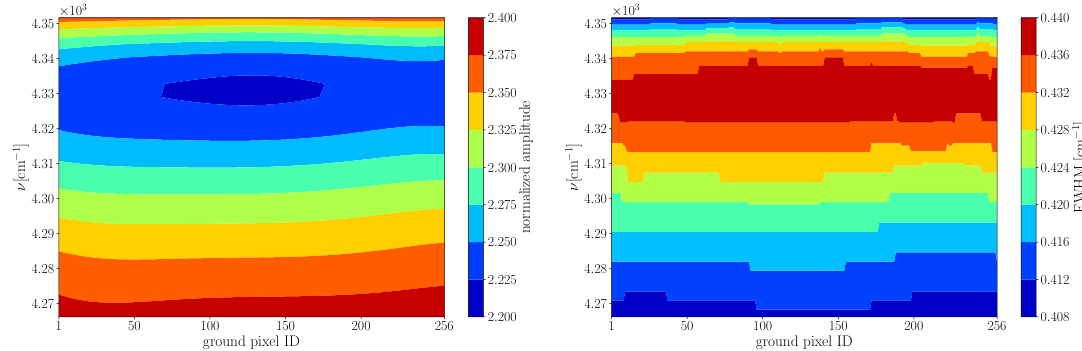
Figure 4. Distribution of the maximum normalized amplitudes (left) and corresponding full-width at half maxima (FWHM) (right) for the 24 256 tabulated responses [69]. ×